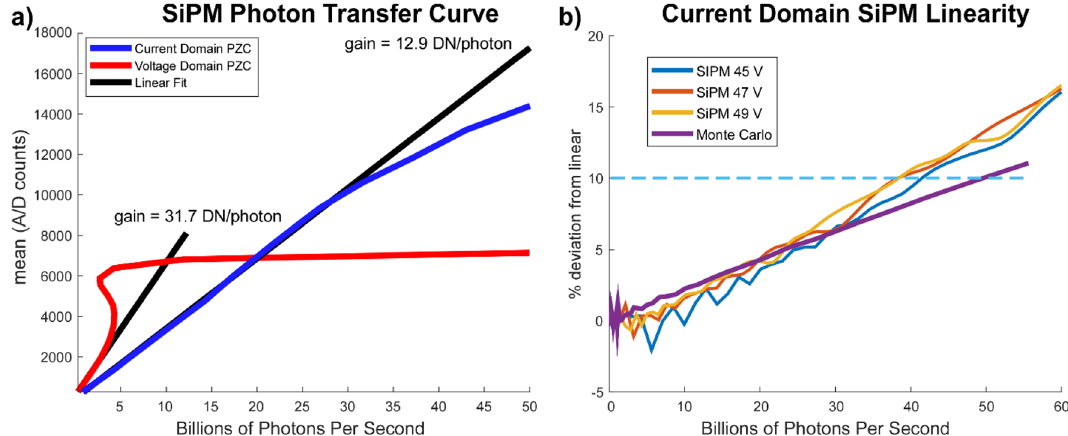
Figure 6. Dynamic range and linearity calculated from the device PTCs. ( a ) The original voltage domain PZC configuration saturates at 4 billion photons per second, while the improved current-domain PZC extends the 10% nonlinearity point to 40 billion photons per second. Both exceed the overcurrent protection circuit limit on the H10770 of approximately 3 billion photons per second. ( b ) PTC deviation from linear as a function of detected photons for the current-domain S14420-3025 at three bias voltages compared to simulated PTCs using the Monte Carlo model. Overall agreement is excellent until 30 billion photons per second, when the bias generator current limits begin to gradually drop the bias voltage. The oscillation in linearity is a measurement artifact due to minor ringing in the bias generator voltage in response to the square wave excitation and is most significant at lower gains due to proximity to the breakdown